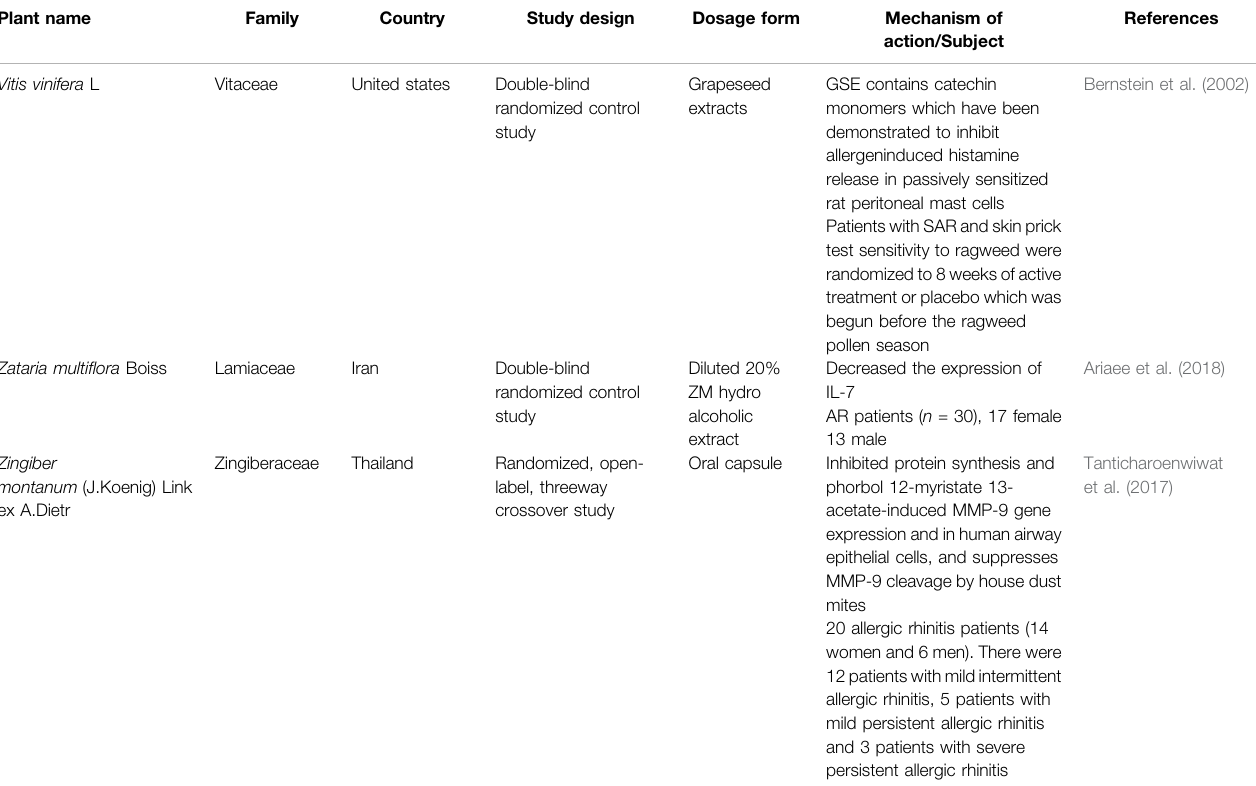
TABLE 2 | ( Continued ) Clinical trials studies of plants with anti-allergic